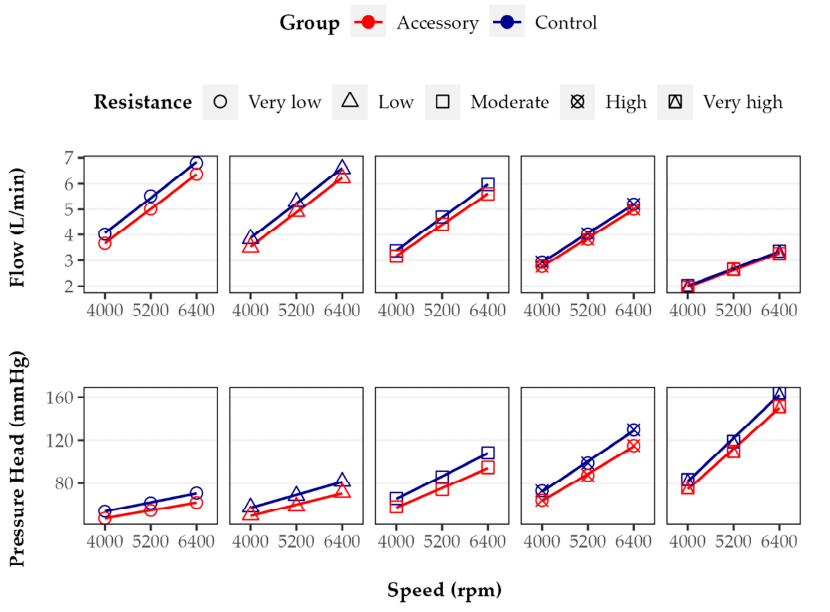
Figure 2. Flow and pressure head of Accessory and Control groups at five different resistance levels (points) with linear regression curves (lines). In both groups, flow and pressure head increased di- rectly proportional to pump speed. Flow and pressure head were lower in the Accessory group than in Control group. While fl ow decreased with increasing resistance level, pressure head increased.